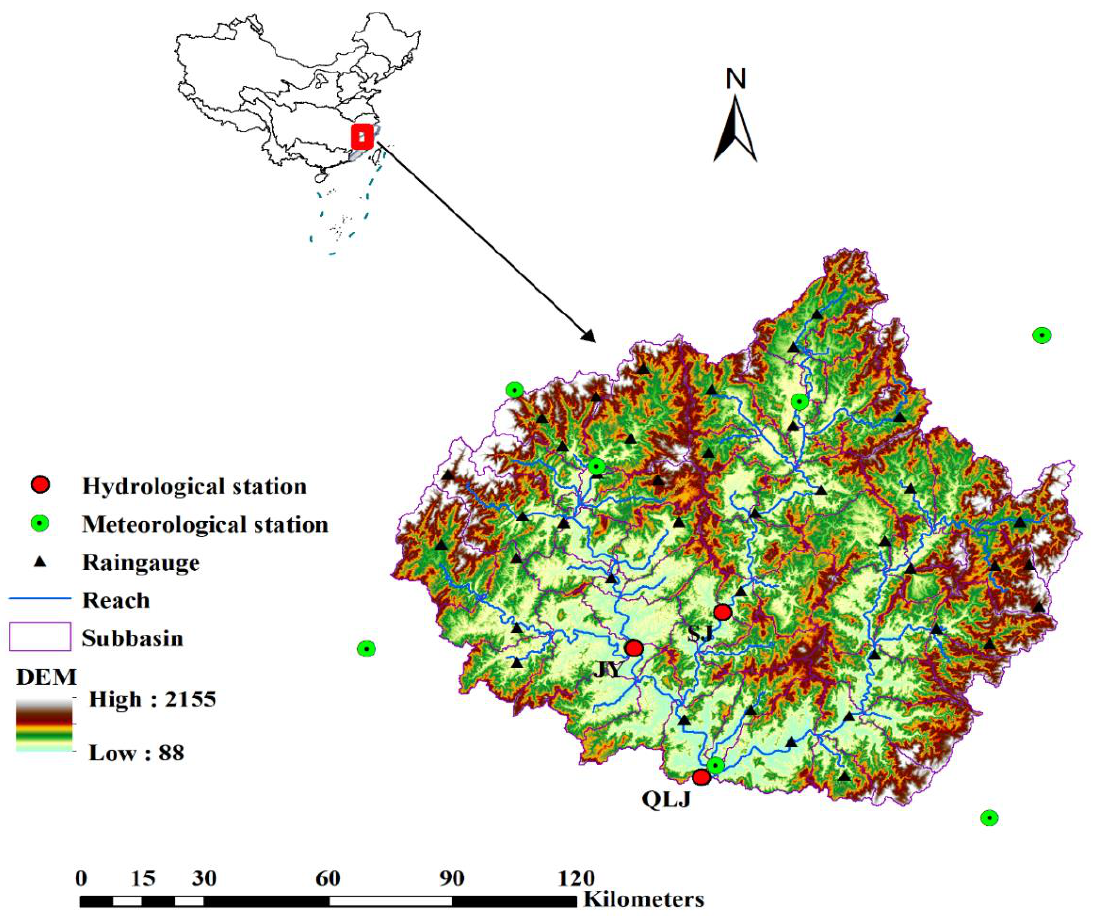
Figure 1. Location of Qilijie Basin and its stations.